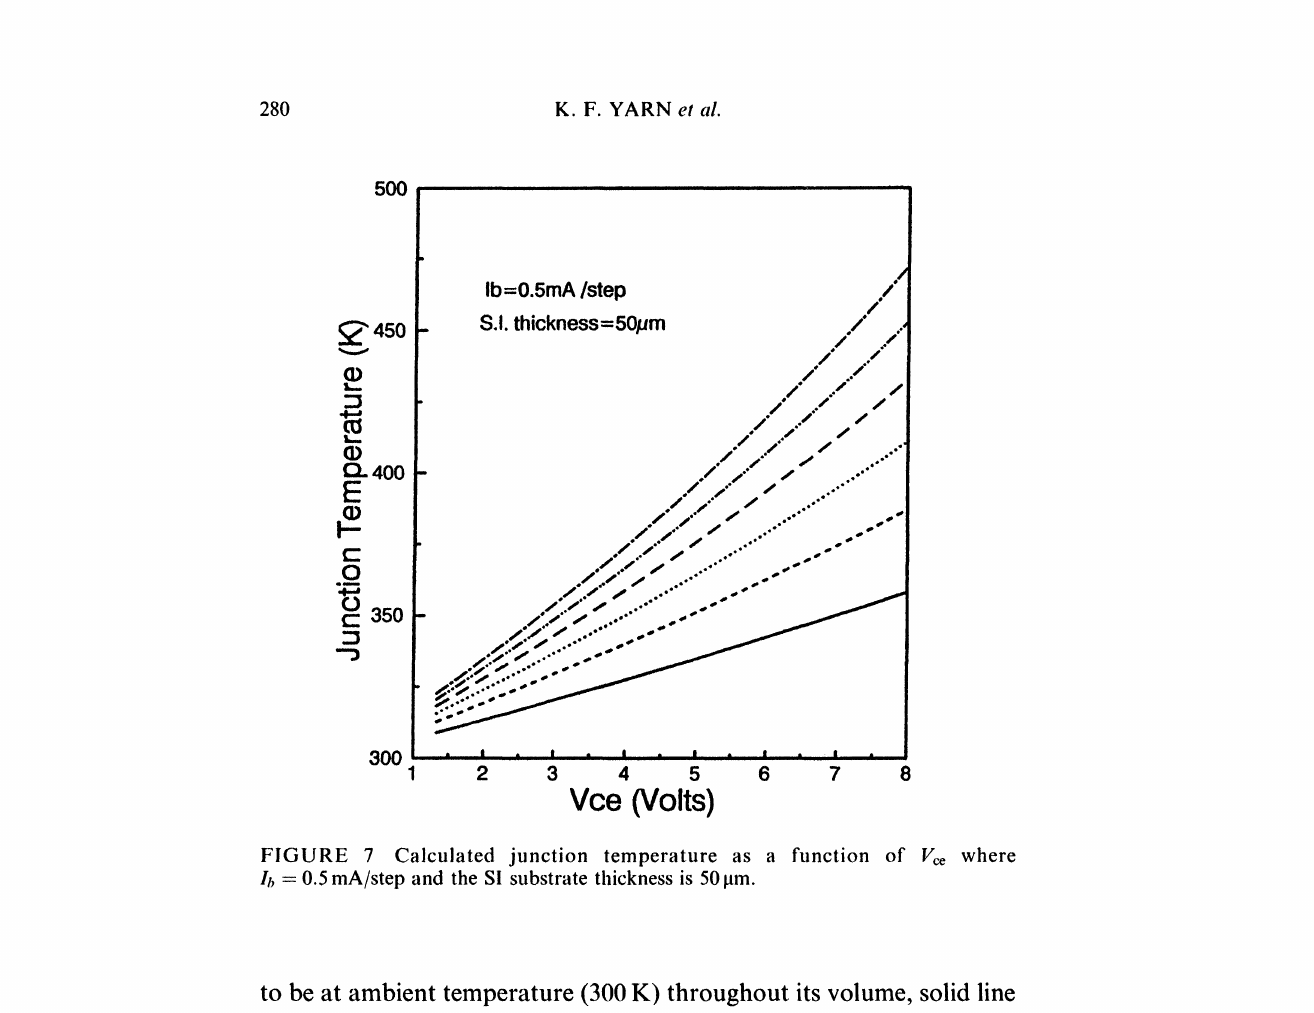
to be at ambient temperature (300 K) throughout its volume, solid line indicate that current gain fl rises monotonically with collector